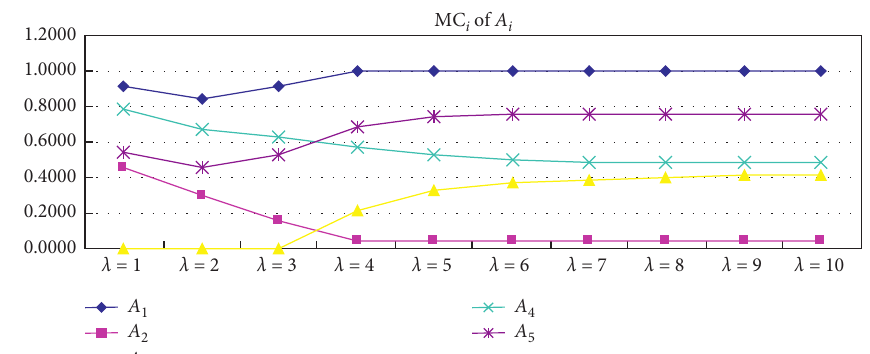
i based on MGPL-ETOPSIS. MC of A i i